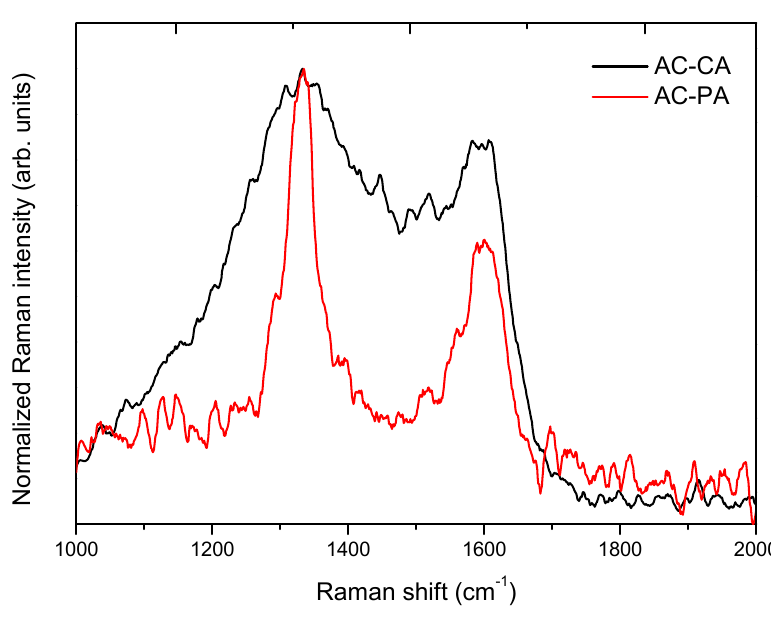
Figure 4. Normalized Raman spectra of both activated carbons.